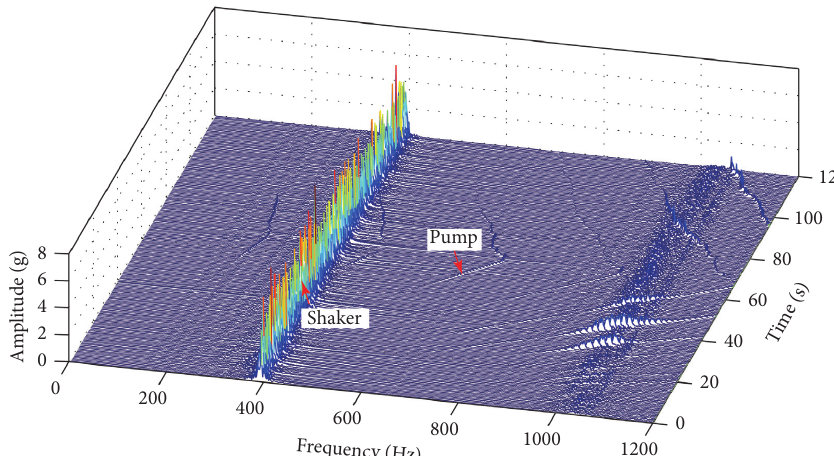
Figure 13: Three-dimensional waterfall of vibration response under pump pressure pulsation frequency and base random